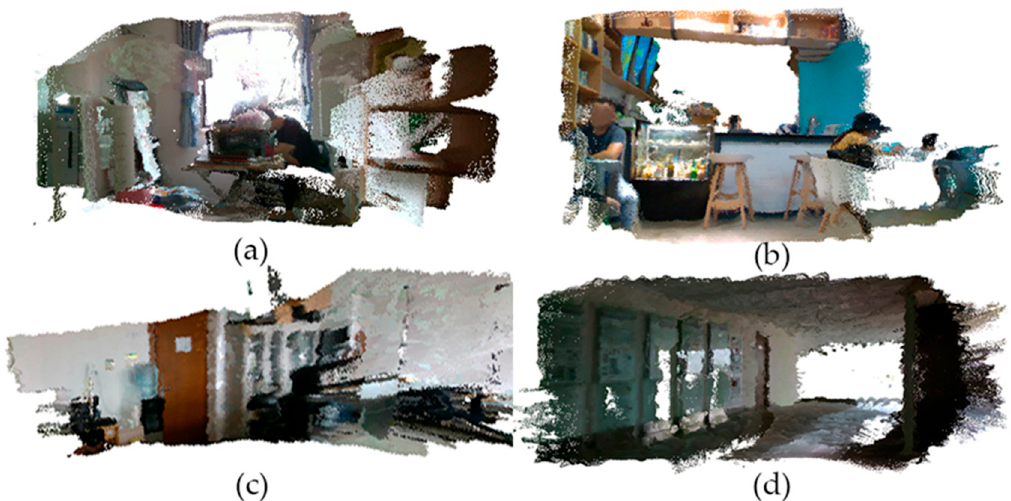
Figure 3. Three-dimensional model constructed from RGB-D image: ( a ) Home scene; ( b ) cafe scene; ( c ) office scene; ( d ) corridor scene.